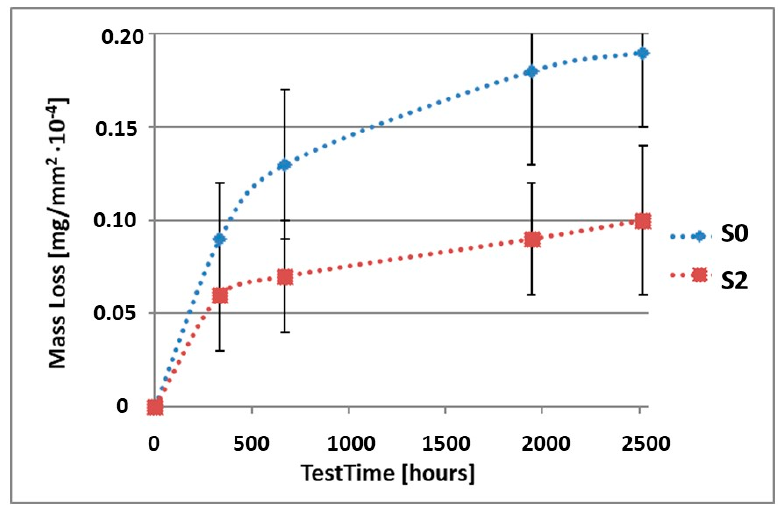
Figure 7. Comparison of the mass losses of samples S0 and S2 for tests in CASS environment.